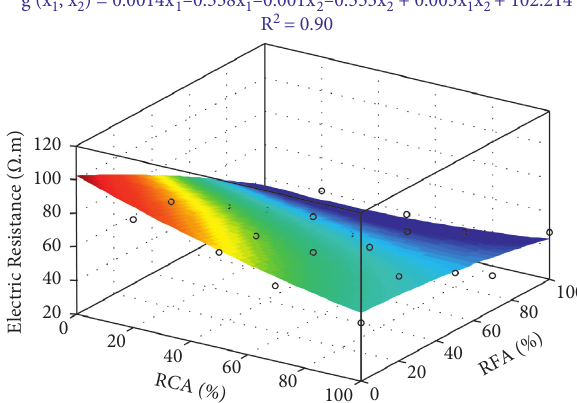
Figure 14: Electric resistance RCA-RFA RSM response.